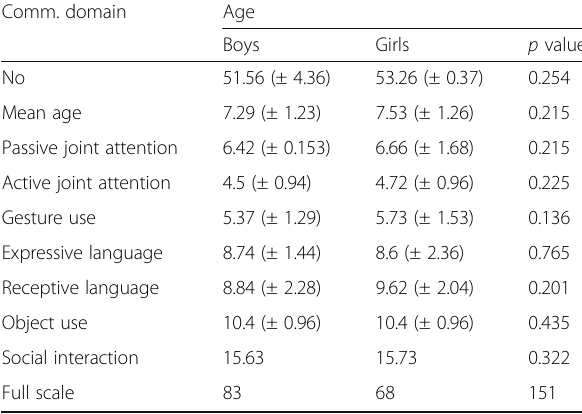
Table 10 The mean scores of both sexes in different